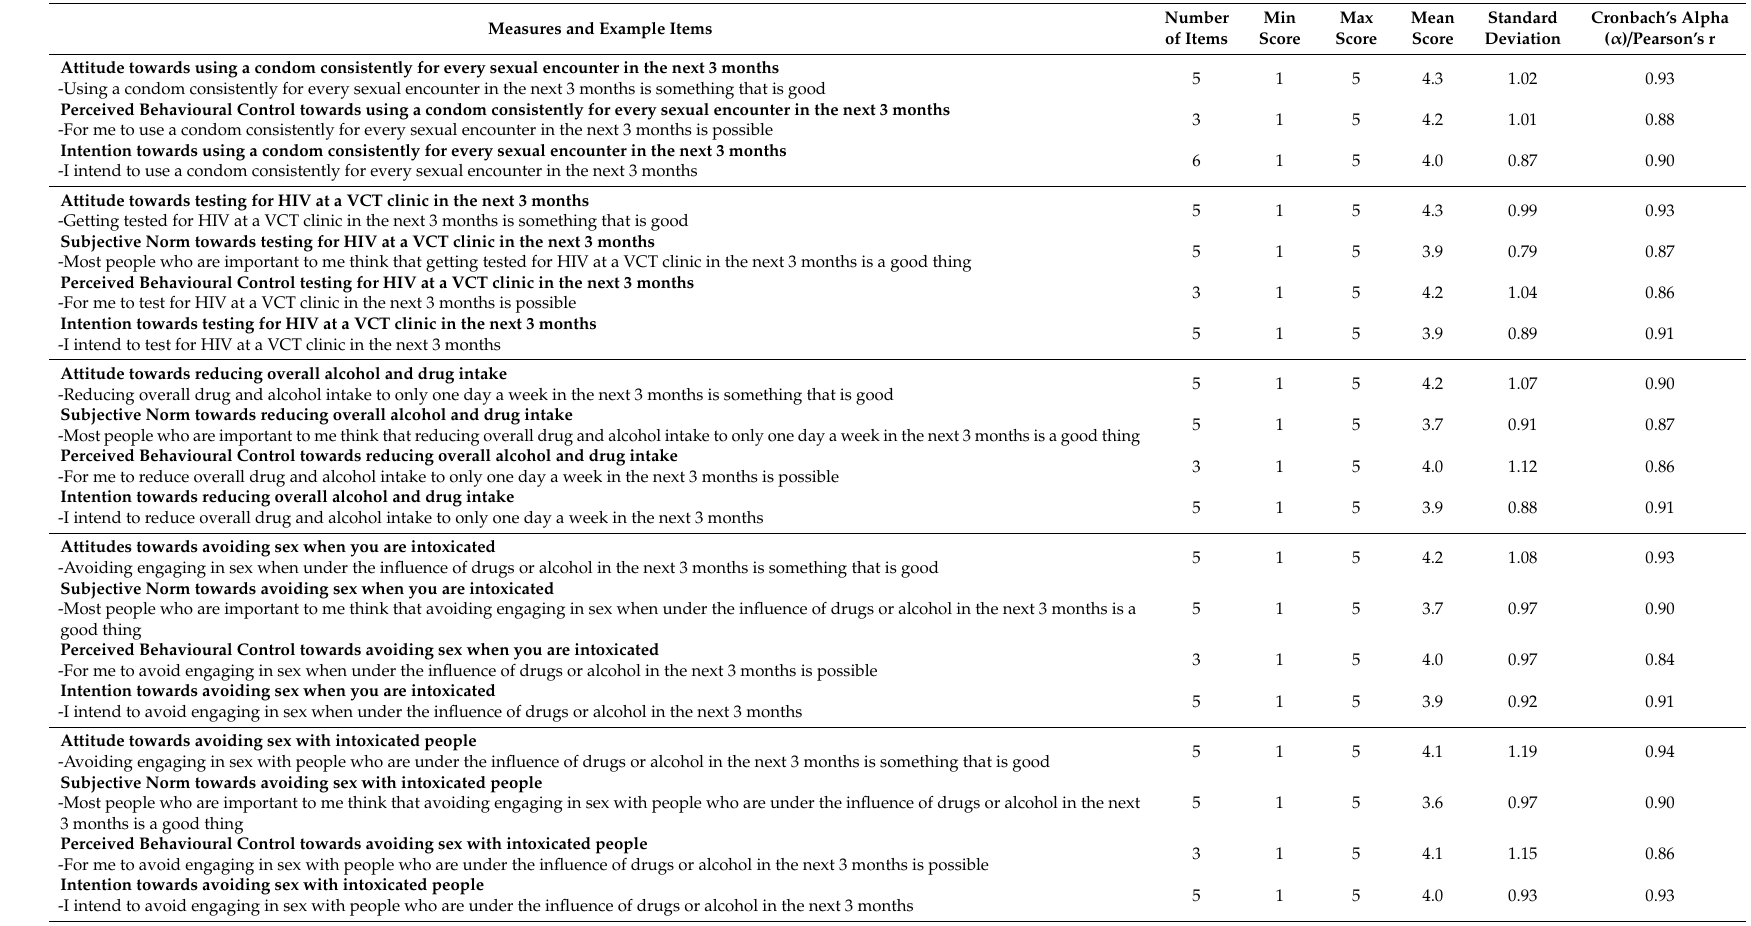
Table A2. Overview of the scale measures for post-test